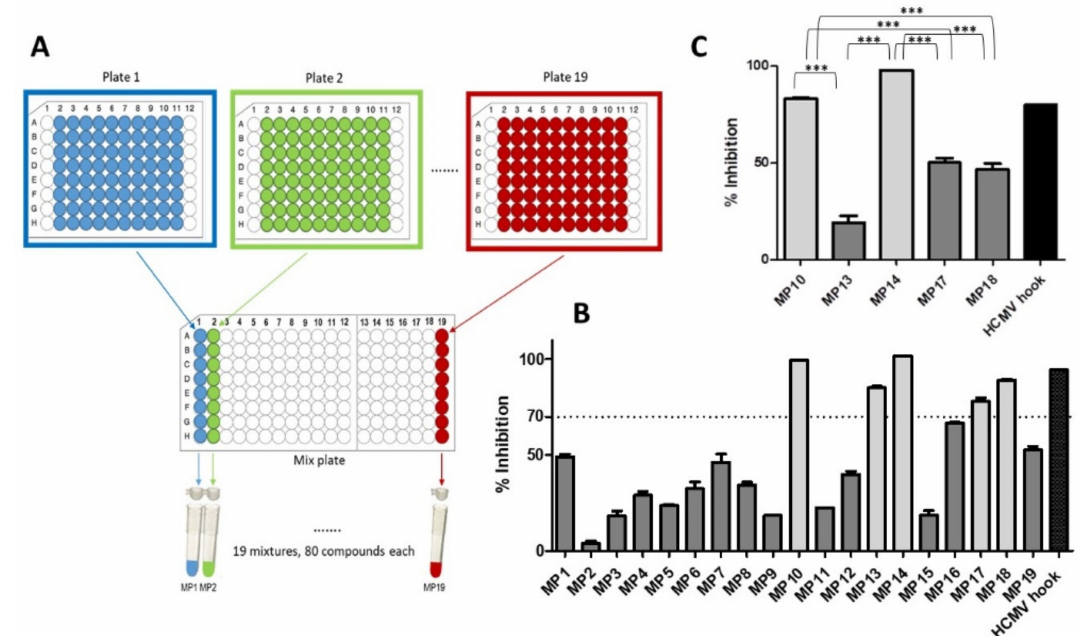
Figure 1. Screening of the Prestwick Chemical Library ® for inhibition of the human cytomegalovirus (HCMV) pUL50-pUL53 interaction. ( A ) Scheme of pooling the library compounds into 19 mixtures (MP1 through MP19). ( B ) Inhibition of the HCMV pUL50-pUL53 interaction by the 19 mixtures, as well as the peptide presenting the N-terminal helical hook of HCMV pUL53 (HCMV hook) at 1.25 µ M/compound. ( C ) Inhibition of the HCMV pUL50-pUL53 interaction by selected mixtures at 0.42 µ M/compound. Error bars present SEMs of at least two experiments. Statistical significance was calculated using the ANOVA test with a subsequent Bonferroni’s multiple comparison test. P -values ≤ 0.05 were considered significant, as indicated by ***. See Section 2.1 for experimental